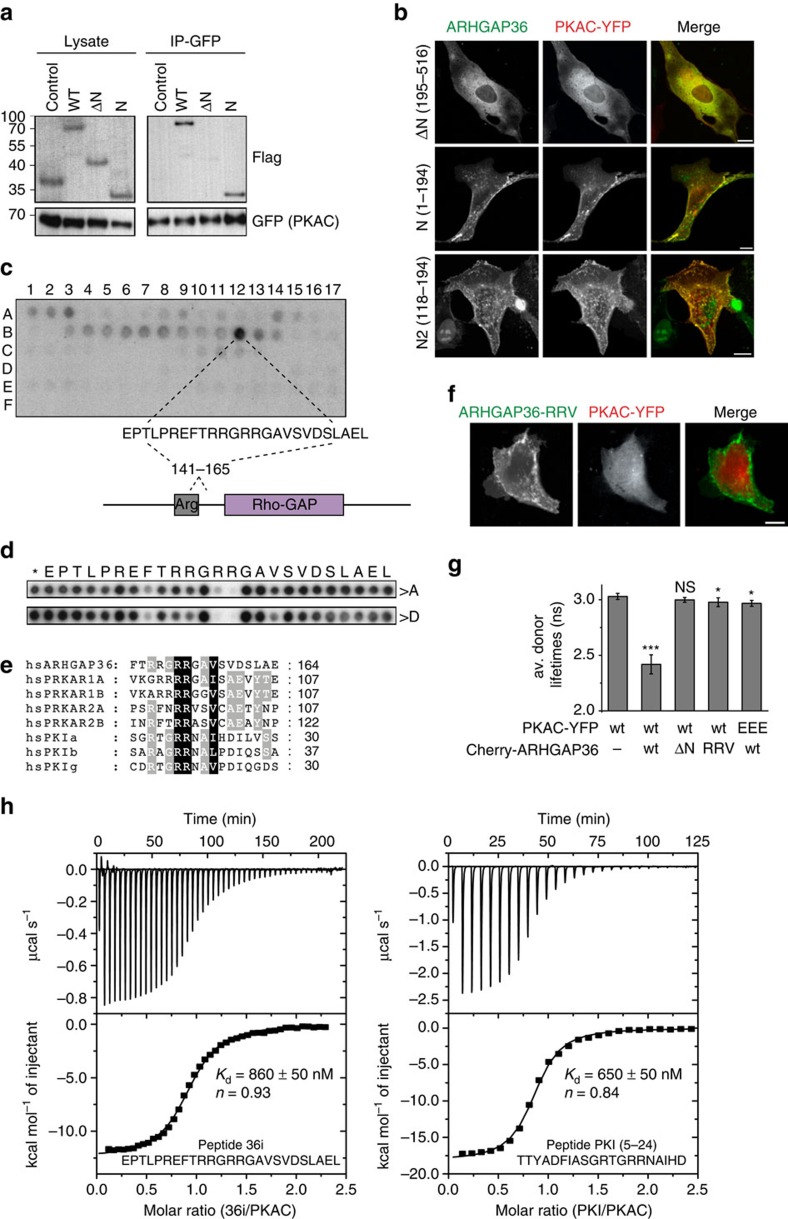
ARHGAP36 interacts with PKAC via a pseudosubstrate domain.(a) HEK293T cells were transfected with PKAC-YFP together with Flag-tagged wild-type ARHGAP36 (WT), 195–516 (ΔN), 1–194 (N) or Flag-Cherry control. Lysates were immunoprecipitated using a GFP antibody and immunoblotted using GFP or Flag antibodies. (b) Confocal live micrographs of MDCK cells expressing PKAC-YFP together with CFP-ΔN, CFP-N or CFP-N2 (118–194). Nuclear enrichment of ARHGAP36-N2, bottom left, may be facilitated by the arginine-rich sequence. Scale bars, 10 μm. (c) Immobilized peptide ‘spots', overlapping 25-mer peptides each shifted along by 5 aa in the entire ARHGAP36 sequence, were probed for interaction with GST-PKAC and immunoblotted using a GST antibody. The sequence of the spot with strongest interaction is shown. (d) Alanine and aspartate scans of the spot indicated in c were treated the same as in c. Asterisk indicates wild-type sequence spot. (e) Alignment of human ARHGAP36 with the human isoforms of PRKAR and PKI revealing its pseudosubstrate motif RRxAY. (f) Confocal live micrographs of MDCK cells coexpressing CFP-ARHGAP36-RRV and PKAC-YFP. Scale bars, 10 μm. (g) Average Venus-YFP fluorescence lifetimes of MDCK cells expressing PKAC-YFP alone or together with mCherry-ARHGAP36, -ΔN or -RRV, or PKAC-EEE-YFP (E127A/E170A/E230A) together with mCherry-ARHGAP36 (n≥4 each). Error bars denote mean±s.d. ***P<0.001, *P<0.05; NS, not significant; Student's T-test versus PKAC-YFP donor alone. (h) ITC measurements were performed in the presence of 2 mM ATP analogue adenylyl-imidodiphosphate (AMPPNP). A concentration of 30 μM His-PKAC solution (cell) was titrated with 507 μM PKI or 351 μM 36i (syringe) until saturation was reached using 8 or 6 μl injections, respectively (the first injection was always carried out with half the volume and omitted from data analysis). 36i and PKI bound to PKAC●AMPPNP with almost identical affinities. The measured values are in a similar range as previously reported for the PKAC–PKI interaction in the presence of other ATP analogues or ADP71.